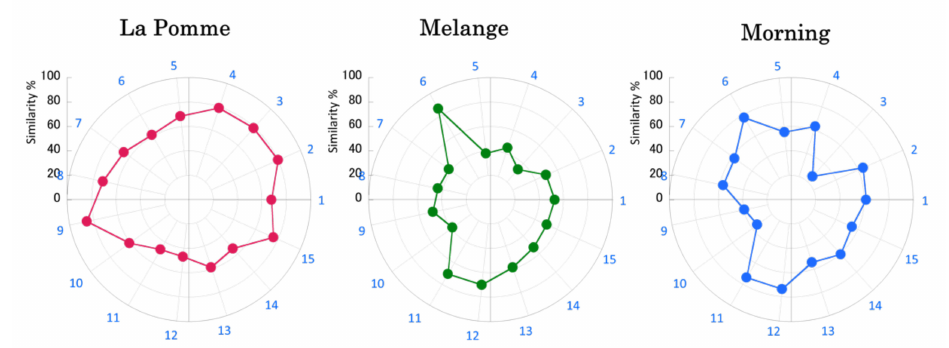
Figure 4. Similarity between the fragrances of three herbal teas and those of 15 herbs by FF-2A measurement. The similarity (%) is represented by the distance from the center of the circle. The numbers in blue correspond to the fragrance of the herb. 1. Mallow, 2. German Chamomile, 3. Hibiscus, 4. Peppermint, 5. Linden, 6. Echinacea, 7. Elder, 8. ST.John’s Wort, 9. Dandelion, 10. Nettle, 11. Passionflower, 12. Mate, 13. Mulberry, 14. Raspberry Leaf, 15. Rose